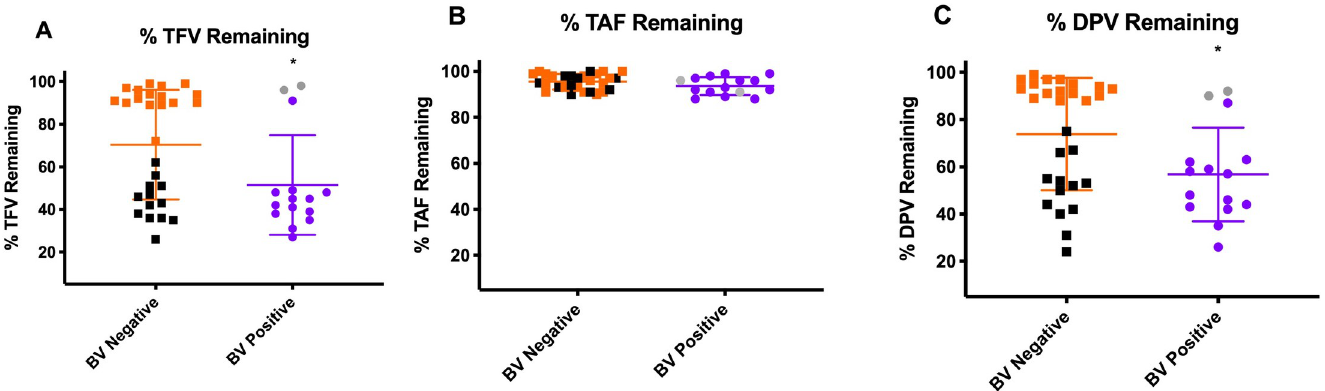
Fig 4. Fraction of drug remaining based on Nugent score diagnosed BV+/- women. (A) % TFV remaining after 24 hours at 37C in BV diagnosed vs non-BV diagnosed CVLs. Orange, BV negative; Purple, BV positive. Black dots indicate less than 50% Lactobacillus dominance despite BV negative diagnoses. Gray dots indicate greater than 50% Lactobacillus dominance despite BV positive diagnoses. (B) % TAF remaining after 24 hours at 37C in BV diagnosed vs non-BV diagnosed CVLs. Orange, BV negative; Purple, BV positive. Black dots indicate less than 50% Lactobacillus dominance despite BV negative diagnoses. Gray dots indicate greater than 50% Lactobacillus dominance despite BV positive diagnoses. (C) % DPV remaining after 24 hours at 37C in BV diagnosed vs non-BV diagnosed CVLs. Orange, BV negative; Purple, BV positive. Black dots indicate less than 50% Lactobacillus dominance despite BV negative diagnoses. Gray dots indicate greater than 50% Lactobacillus dominance despite BV positive